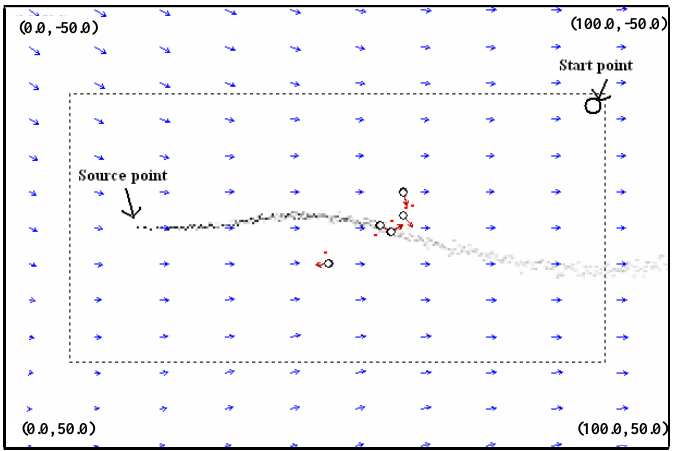
Figure 21. The CPT scene at time t = 420 s for the medium-wandering plume environment (five robots are used).